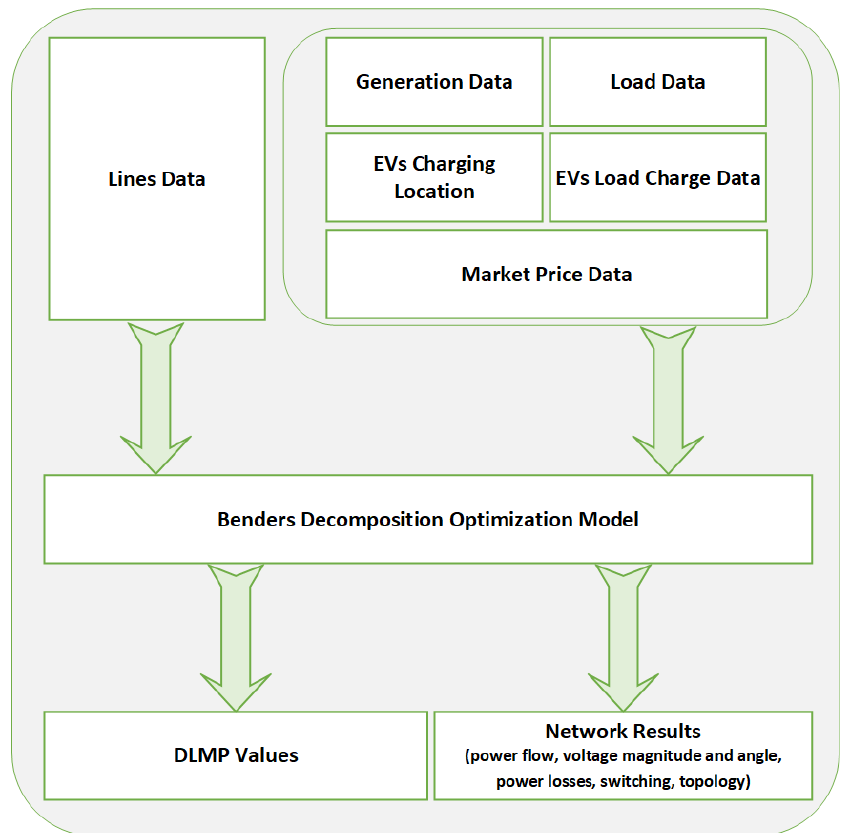
Figure 4. Diagram of the distribution operation optimization